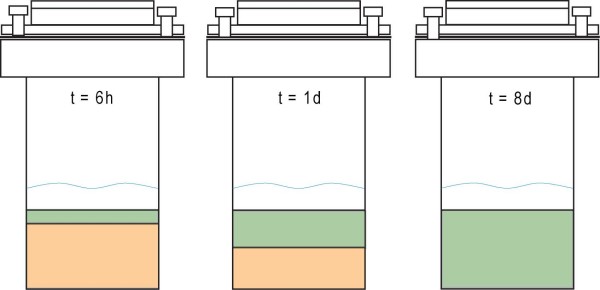
Schematic representation of static batch reactions for t = 6 h, 1 day, and 8 days (10:1 batch mixture). At early reaction times, the solid cake consists of two distinct layers in which the top layer is tobermorite (green) and the bottom is unreacted Al-CSH gel (orange). Water is shown in blue. These diagrams illustrate that the amount of tobermorite increases with reaction time and is complete after 8 days of heating.